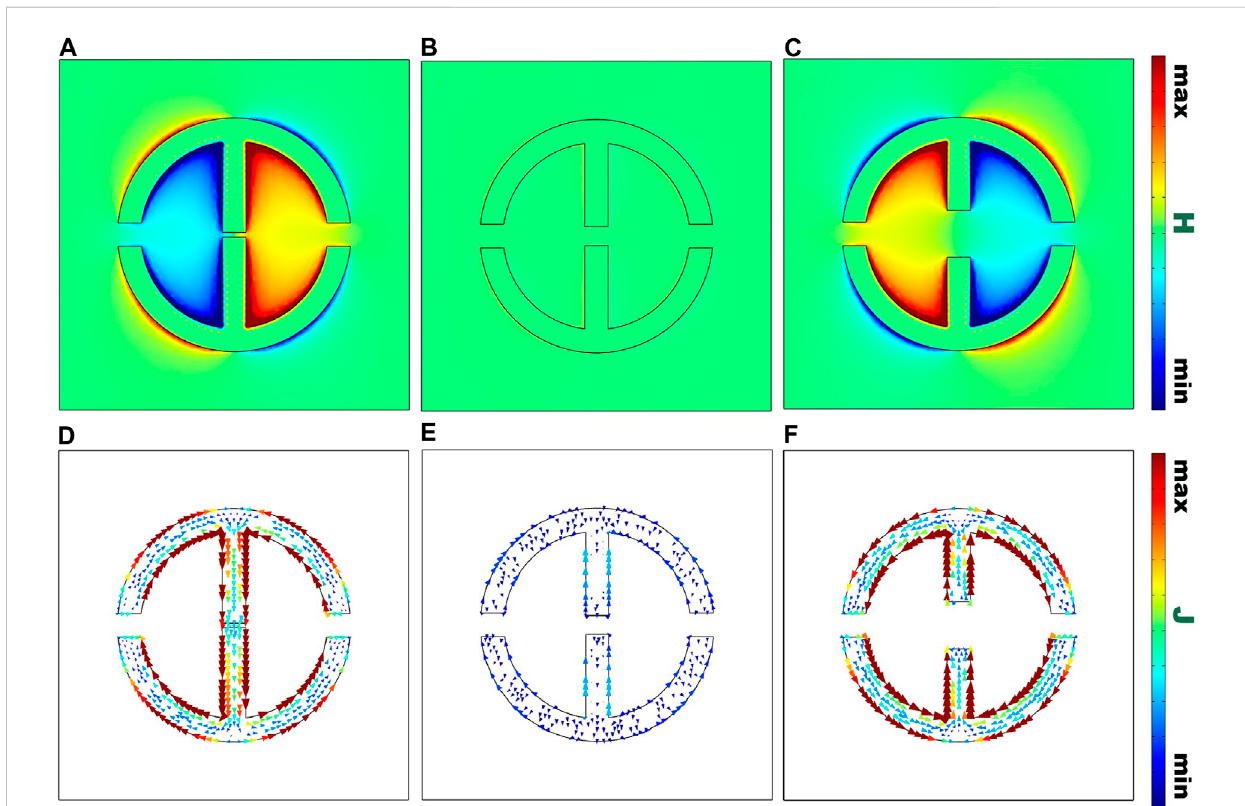
FIGURE 4 (A) Z direction magnetic fi eld strength corresponds to the quasi-BIC mode of g 2 = 2 µm. (B) Z direction magnetic fi eld strength corresponds to the BIC mode of g 2 = 8 µm. (C) The Z -direction magnetic fi eld strength corresponds to the quasi-BIC mode of g 2 = 20 µm. (D) The x-o-y plane current corresponds to the quasi-BIC mode of g 2 = 2 µm. (E) The x-o-y plane current corresponds to the BIC mode of g 2 = 8 µm. (F) The x-o-y plane current corresponds to the quasi-BIC mode of g 2 = 20